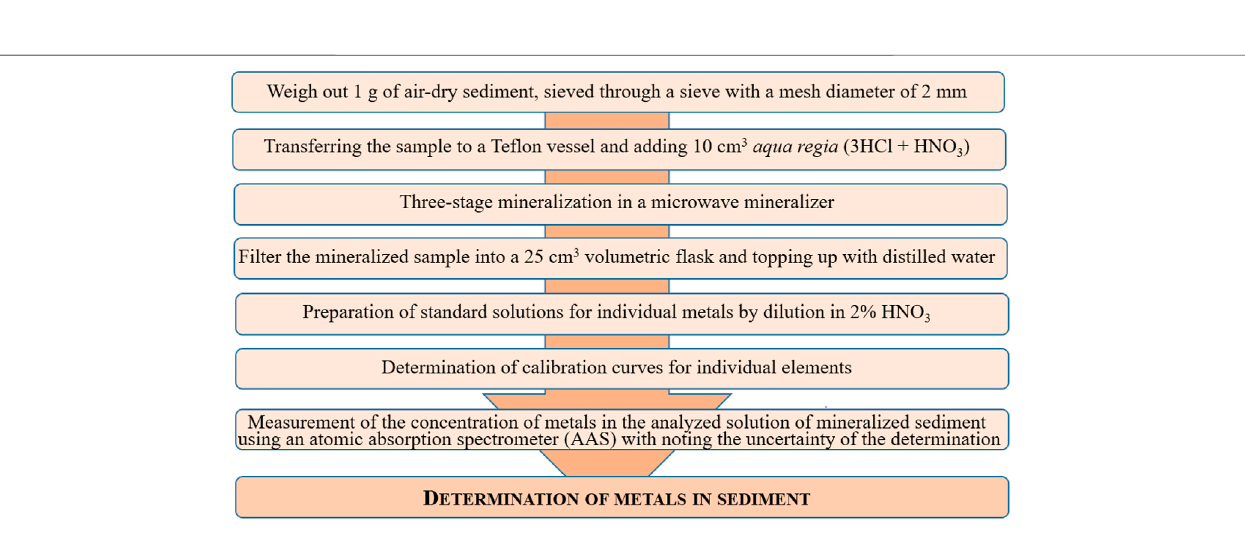
FIGURE 2 | Procedure for the determination of metals in the investigated